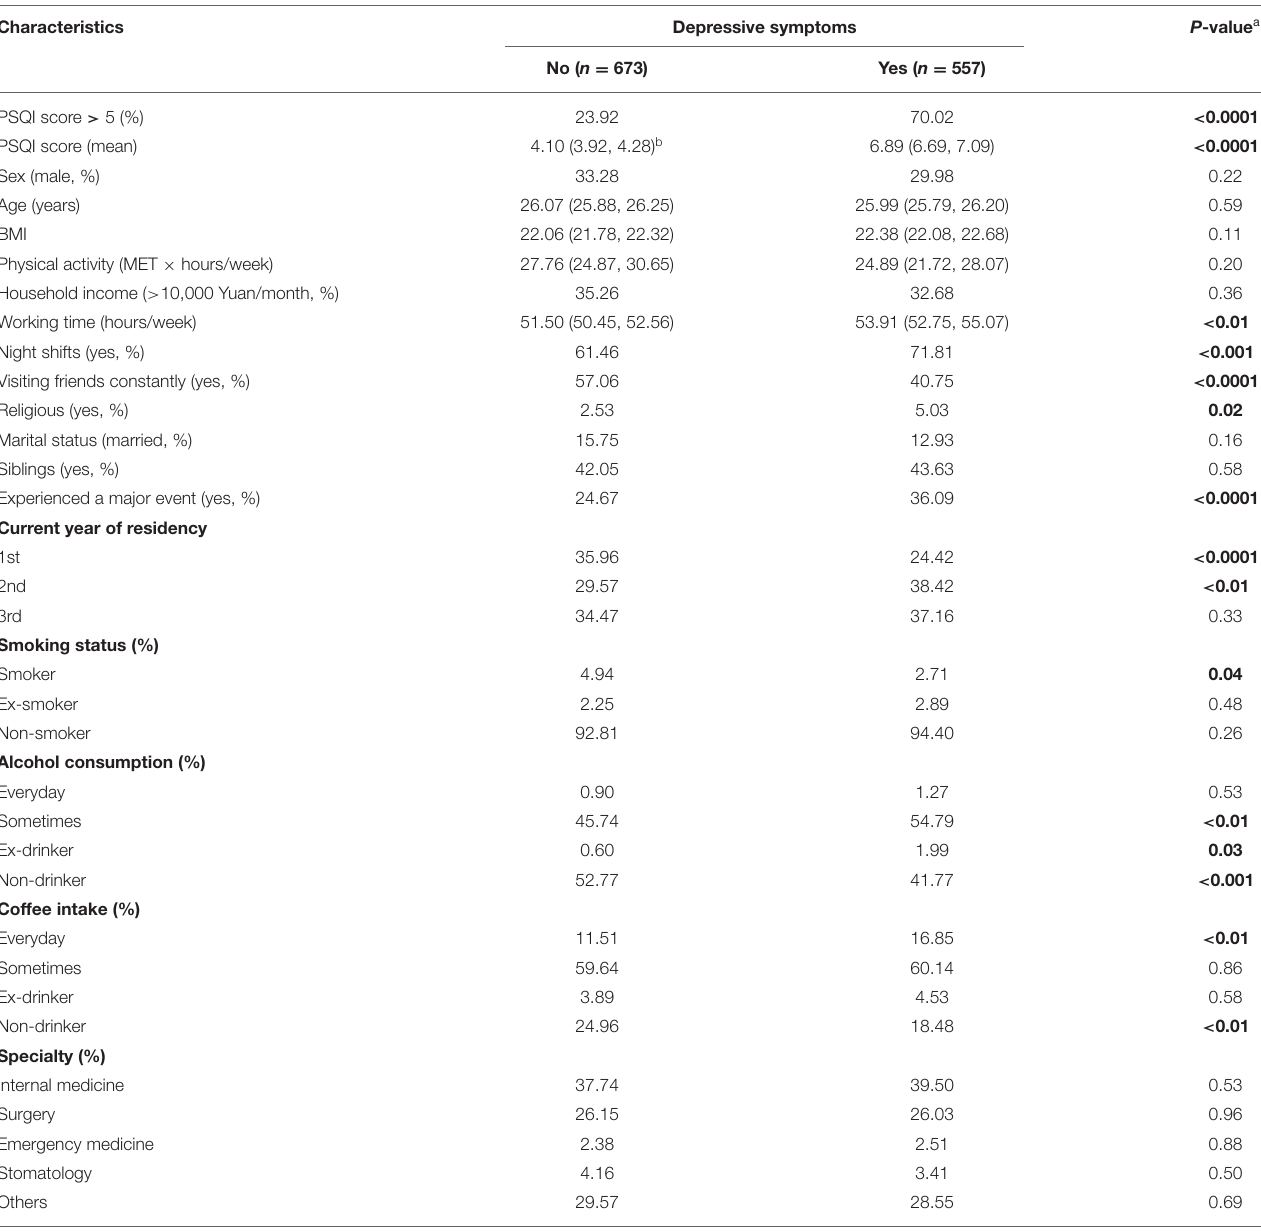
TABLE 1 | Participant characteristics according to depressive symptom (PHQ-9 ≥ 5) status*. Characteristics Depressive